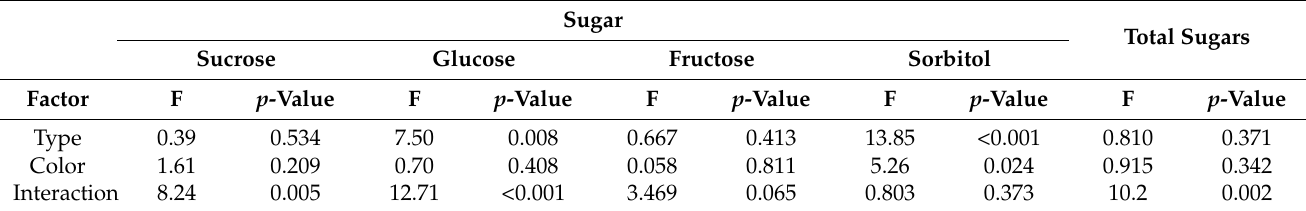
Table 5. Two-way ANOVA of sugar contents for type of fruit (peach vs. nectarine) and color (white vs. yellow) of peach fruits. F statistic and p -value of each factor and their interaction are reported for each